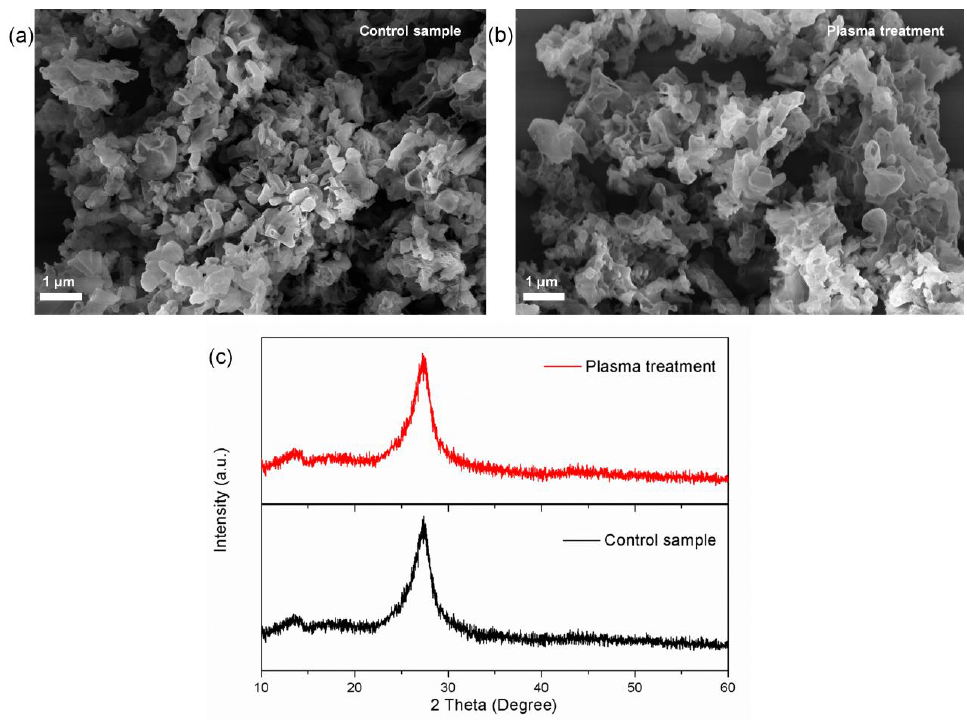
Figure 1. ( a , b ) SEM images, and ( c ) XRD patterns of the samples. (Plasma treatment time: 300 s; power: 60